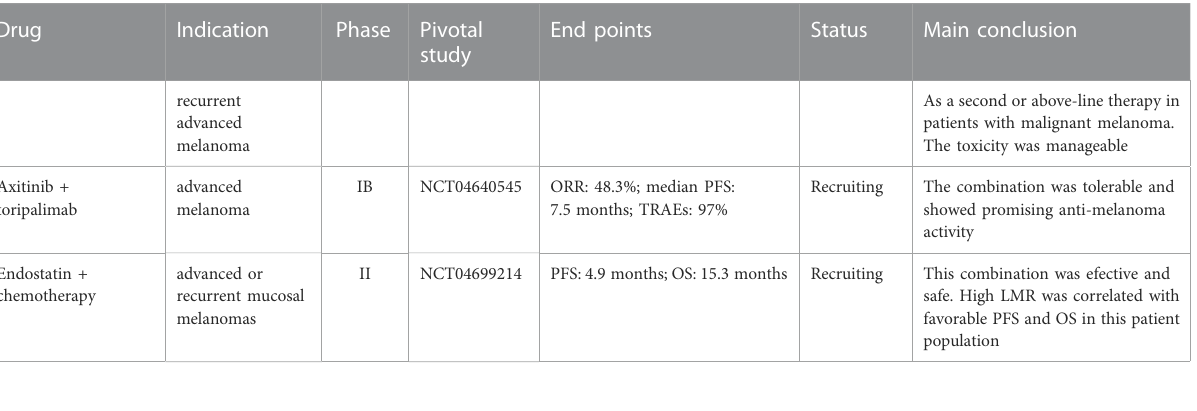
TABLE 3 Summary of evaluation of Traditional Chinese herbal medicine in melanoma.